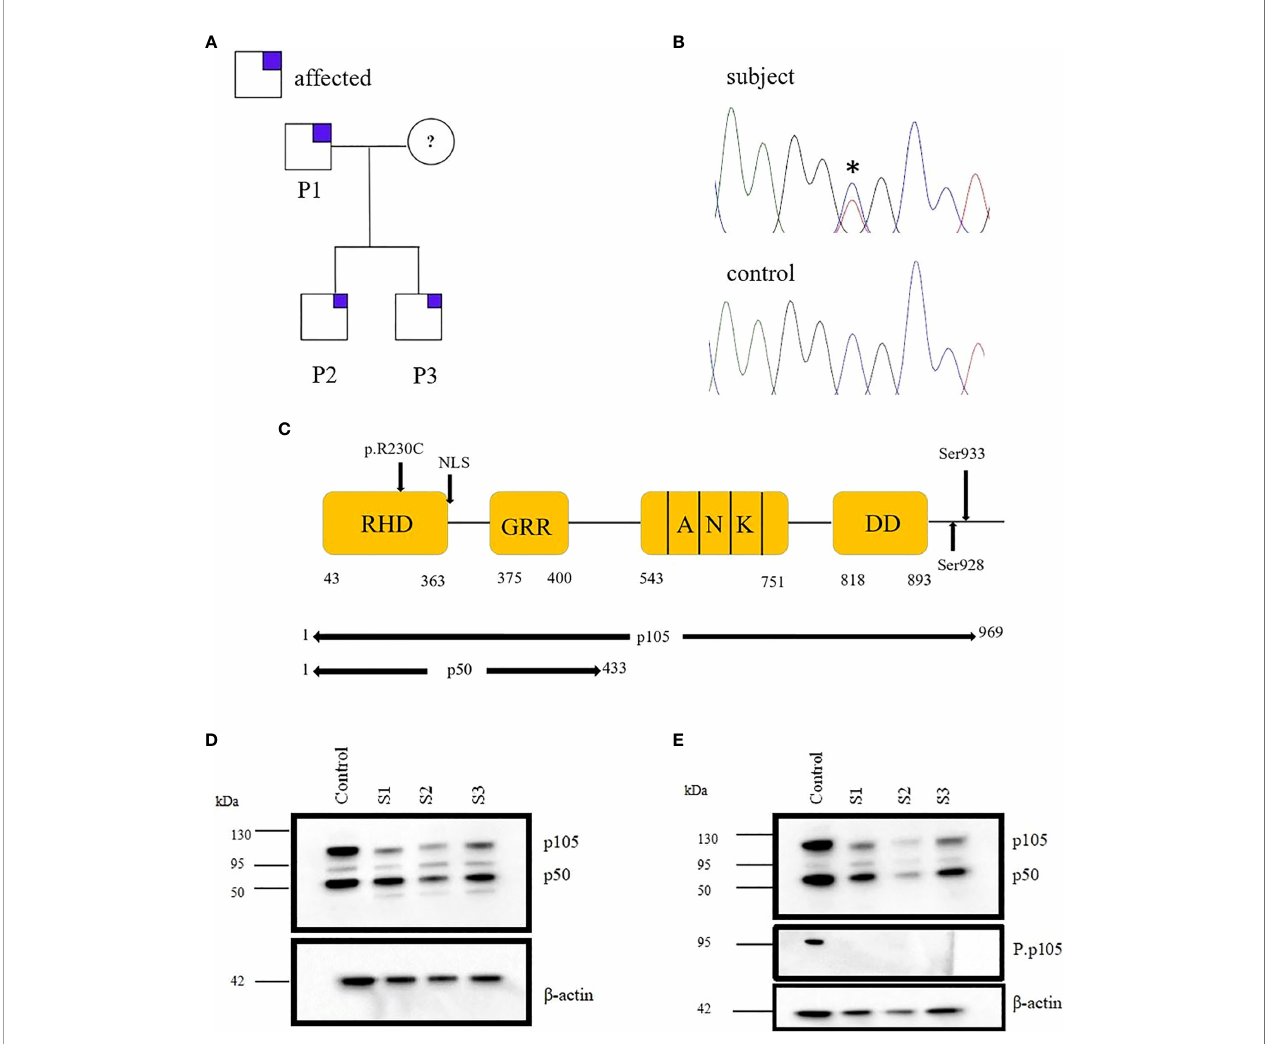
FIGURE 1 | Monoallelic NFKB1 missense mutation in a family with late-onset antibody de fi ciency. (A) Segregation of NFKB1variant was analyzed by sequencing genomic PCR product and revealed an autosomal-dominant inheritance in families with reduced clinical penetrance. The analysis excluded the mother of patients because of material lack. (B) Sanger sequencing of genomic PCR products results in the chromatogram of missense variant and wild type (WT) (C) Structure of NF k B protein showing the position of the identi fi ed mutation. (D) Immunoblotting was performed in PBMCs of subjects (S1, S2, and S3) and healthy control (HC), and the expression of p105/50 was evaluated. The expression of p105 was reduced for all the subjects compared to the control. However, the expression of p50 was reduced in S2. (E) PBMCs from HC and S1, S2 and S3 were stimulated with PMA; 50 ng/ml and ionomycin; 1 m g/ml and the expression of p105/50 evaluated. There were no signi fi cant changes in the p105/50 expression after stimulation in the subjects; however, p105 phosphorylation at serine 933 was detected in only the HC but not in the subject. Beta-actin was used as a cytoplasmic loading